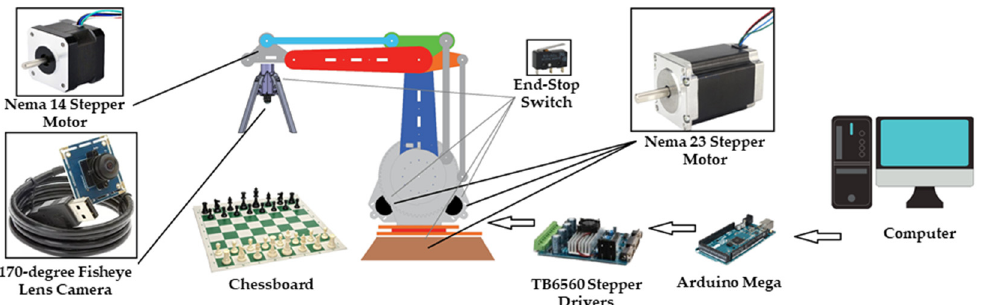
Figure 1. General block diagram of the system.